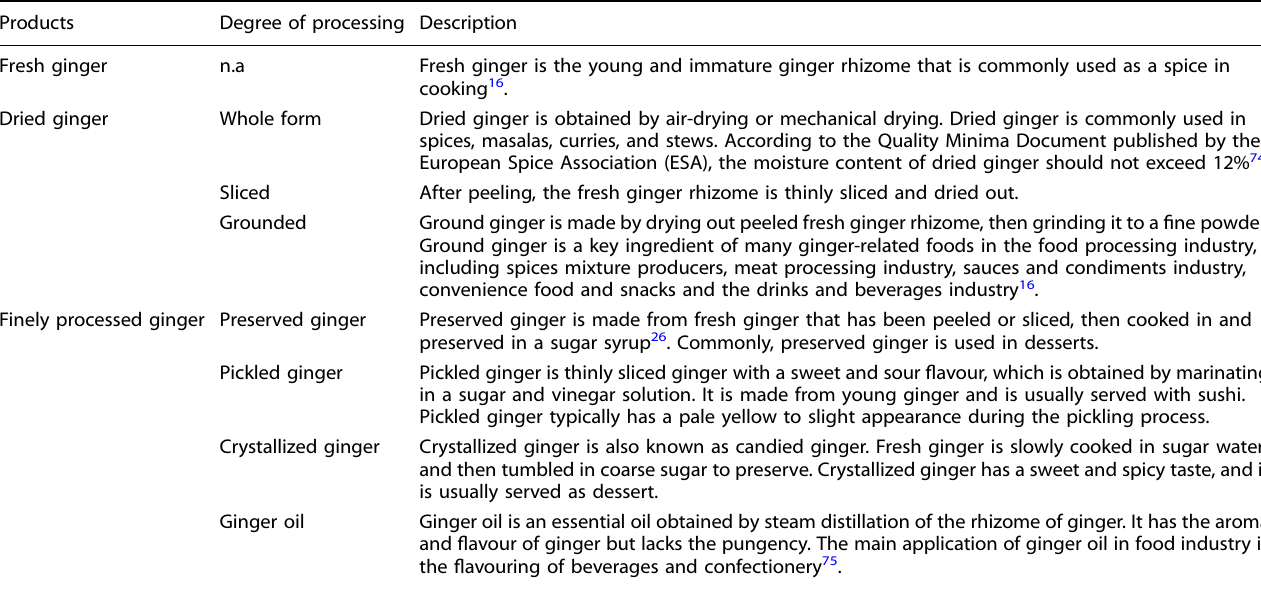
Table 2. Ginger products with food fraud concerns. Products Degree of processing